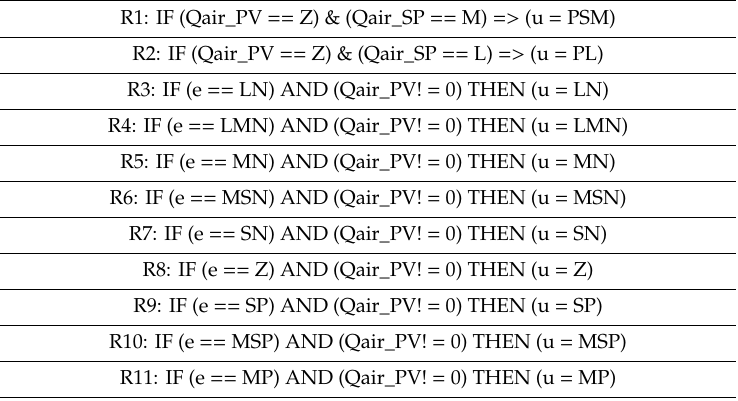
Table 10. The second version of the